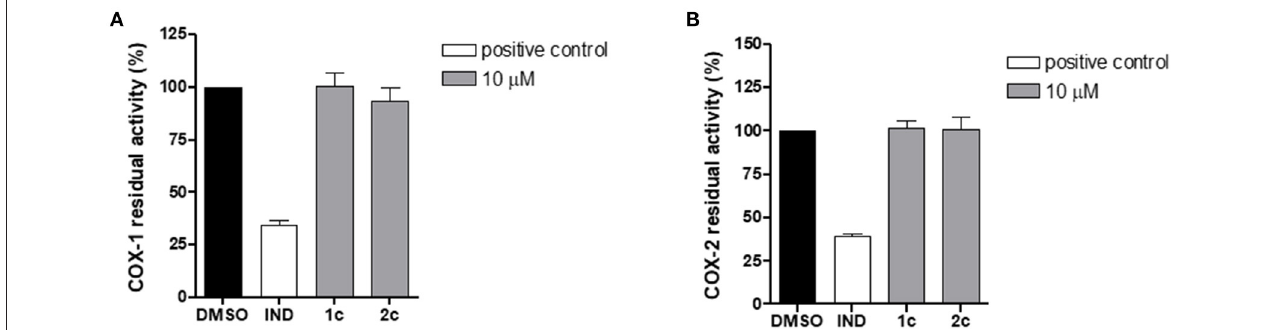
FIGURE 8 | Residual activity of COX-1 (A) and COX-2 (B) after incubation with compounds 1c , 2c , and indometacin (10 µ M) or vehicle (0.1% DMSO). Data are expressed as a percentage of control (100%), n = 3.